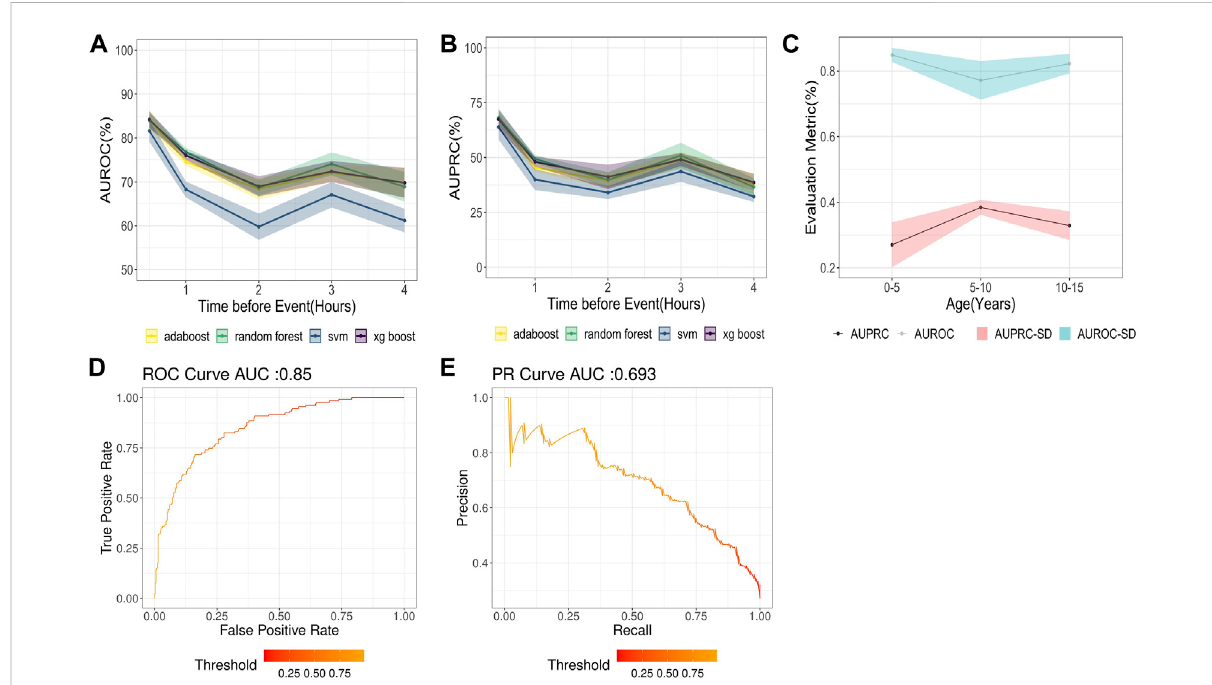
FIGURE 2 (A) AUROC for different models with lead times or times before hypothermia forecast in the next 30 min to 4 h (B) AUPRC for different models with lead times or times before hypothermia forecast in the next 30 min to 4 h (C) AUROC for the Hypothermia prediction in the next 30 min (D) AUPRC for the hypothermia prediction in the next 30 min. (E) Results of the AUROC and AUPRC Models for various age groups.